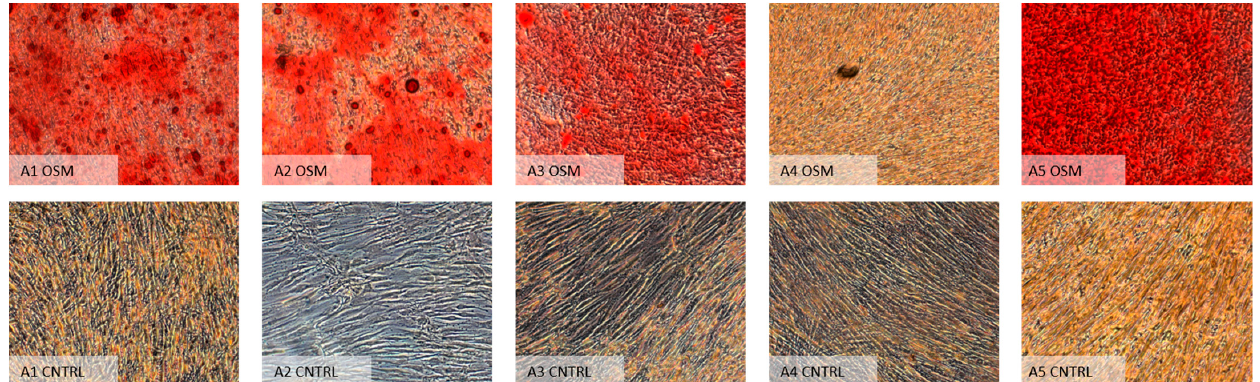
Figure 6. Microscopic images (10×) of all groups from one donor expanded in DMEM LG (condition A), followed by differentiation in specific media according to the individual group (1–5). OSM = osteogenic media, CNTRL = negative control group.